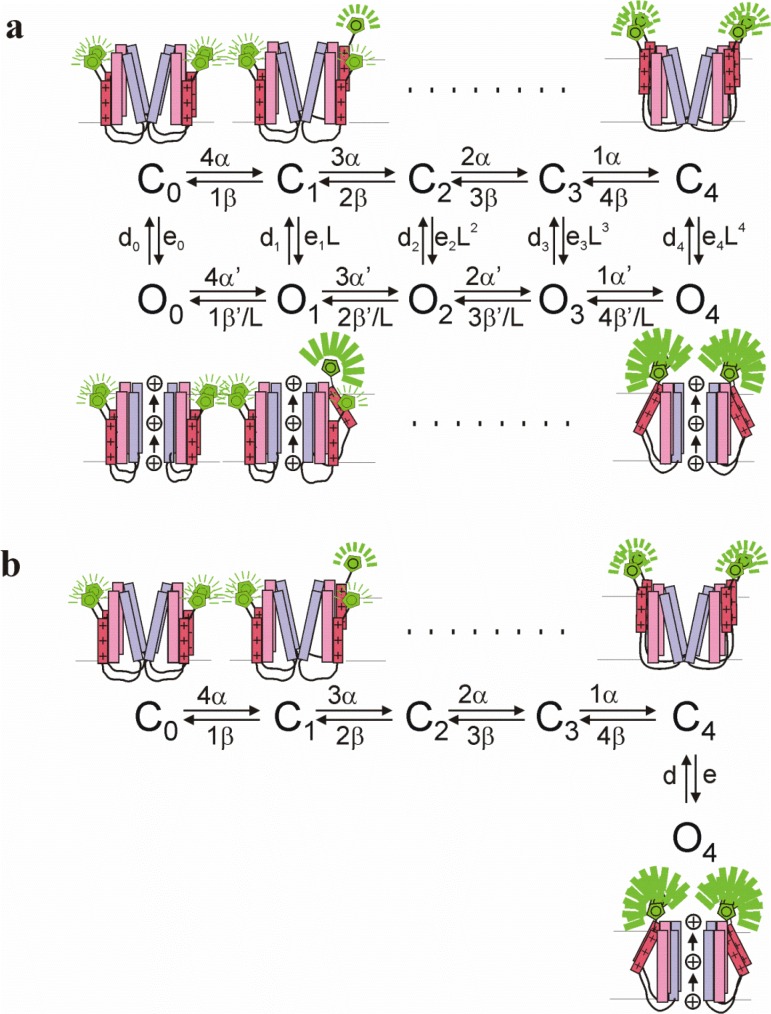
Kinetic models for KV7.1 and KV7.1+KCNE1 channel gating.(a) A 10-state allosteric gating scheme for KV7.1 channels. Horizontal transitions represent independent S4 movements that increase the fluorescence to an intermediate level (which generates the F1 component). The vertical transition represents concerted channel opening with a concomitant additional fluorescence increase (which generates the F2 component). Cartoon shows KV7.1 channel labeled with a fluorophore on S3-S4 with all four voltage sensors in the resting state (C0), with one (C1), or four (C4) voltage sensor activated in the closed channel (top) or with all four voltage sensors in the resting state (O0), with one (O1), or four (O4) voltage sensor activated with the channel opened (bottom). (b) A 6-state allosteric gating scheme for KV7.1+KCNE1 channels. Horizontal transitions represent independent S4 movements that increase the fluorescence to an intermediate level (which generates the F1 component). The vertical transition represents concerted channel opening with a concomitant additional fluorescence increase (which generates the F2 component). Cartoon shows KV7.1 channel labeled with a fluorophore on S3-S4 with all four voltage sensors in the resting state (C0), with one (C1), or four (C4) voltage sensor activated without channel opening (top) that is followed by a concerted conformational change of all four S4s associated with channel opening (O4) (bottom).